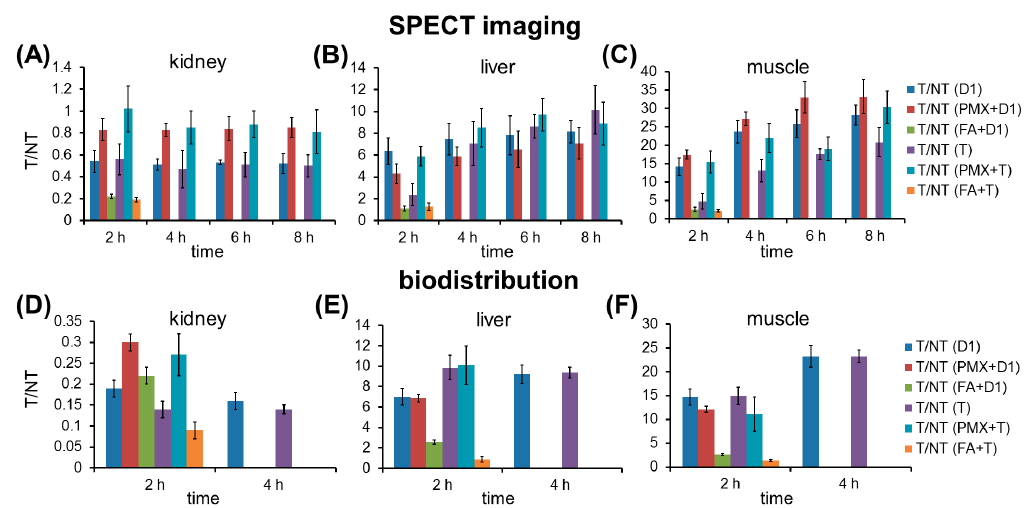
Figure 3. T/NT ratios of 99m Tc-HYNIC-D 1 -FA 2 and 99m Tc-HYNIC-T-FA in SPECT imaging ( A – C ) and biodistribution studies ( D – F ). Uptakes of organs were calculated by drawing ROIs on the SPECT/CT images. D1 = 99m Tc-HYNIC-D 1 -FA 2 ; T = 99m Tc-HYNIC-T-FA. PMX block study: PMX (400 µg) 1 h prior to 99m Tc-HYNIC-D 1 -FA 2 . FA block study: Folic acid (100 µ g) 10 min prior to 99m Tc-HYNIC-D 1 -FA 2 .